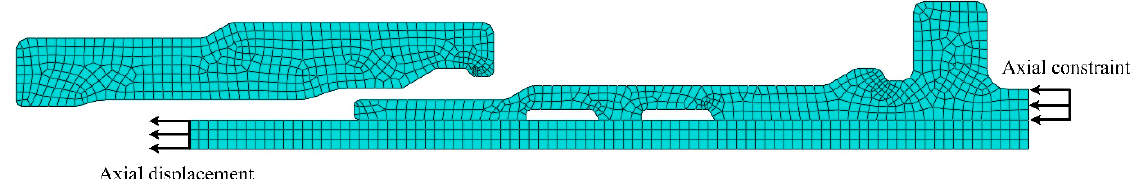
Figure 7. The von Mises stress distribution of axial extrusion joint after extrusion. Figure 8. The von Mises stress distribution of axial extrusion joint after connection-strength experi- ment.